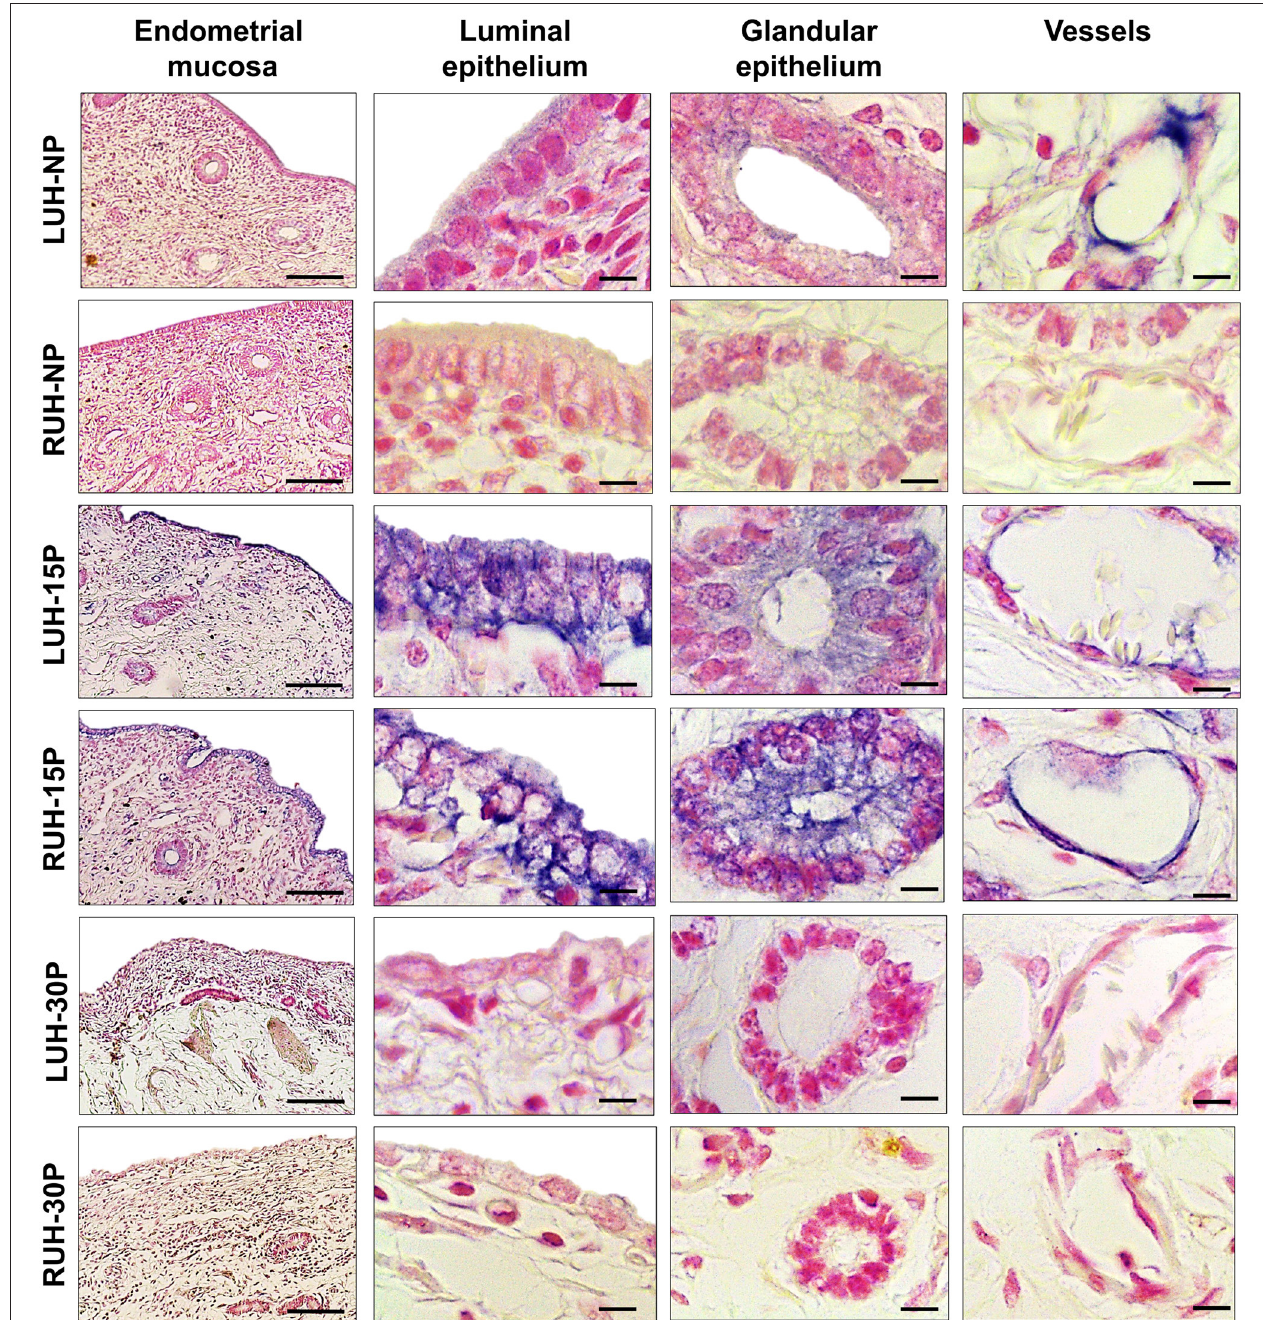
FIGURE 2 | Immunohistochemical localization of β -NGF in the endometrial mucosa of alpacas, positive labeling gives a blue-violaceous coloration. A 10X magnification of endometria of the left uterine horn (LUH) and right uterine horn (RUH) of non-pregnant females (NP); 15 days-pregnant (15P); and 30 days-pregnant females (30P) is presented (scale bar = 100 µ m). Also, a 100X magnification of the luminal, glandular, and vascular endothelium of the different physiological status is shown (scale bar = 10 µ